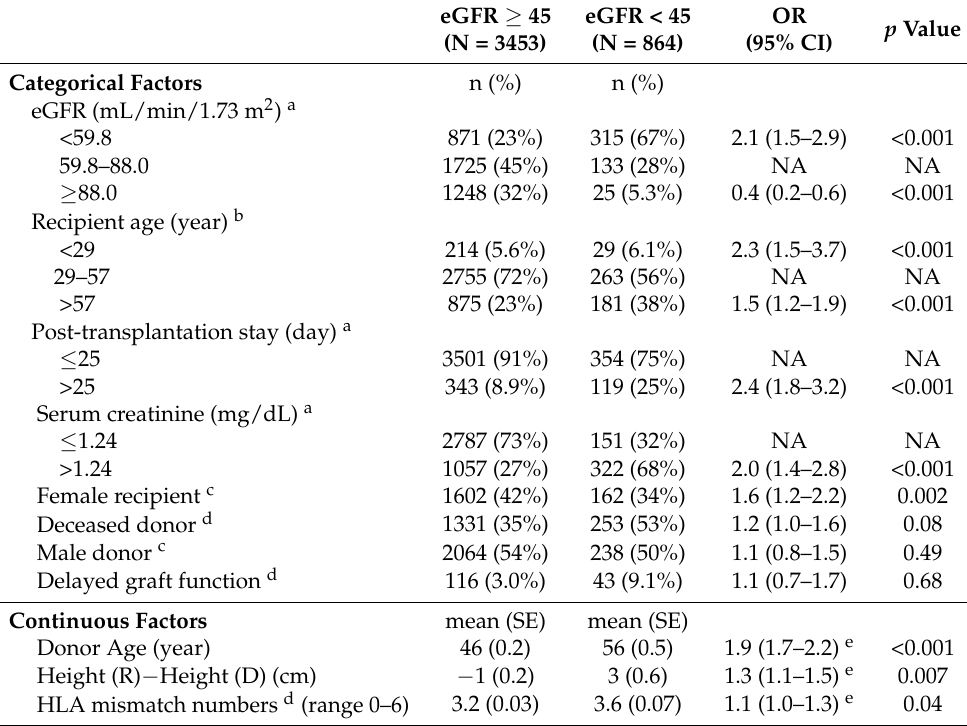
Table 2. Factor analysis for one-year renal allograft dysfunction (multiple logistic